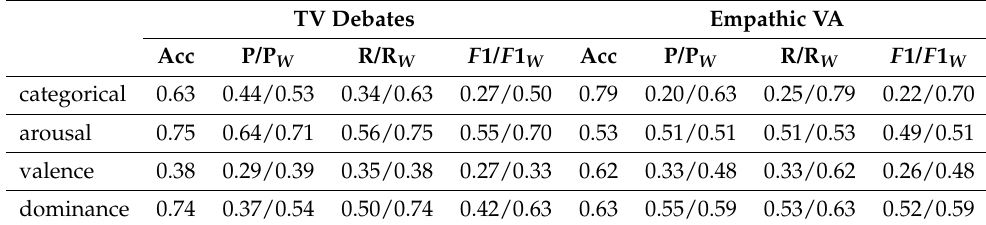
Table 9. Classification results on wav2vec input for each of the problems (categorical and each dimension of the VAD) and corpus (TV Debates and Empathic VA). Each problem shows the accu- racy, and macro and weighted average measures of the metrics (precision, recall, and F 1-score) for all